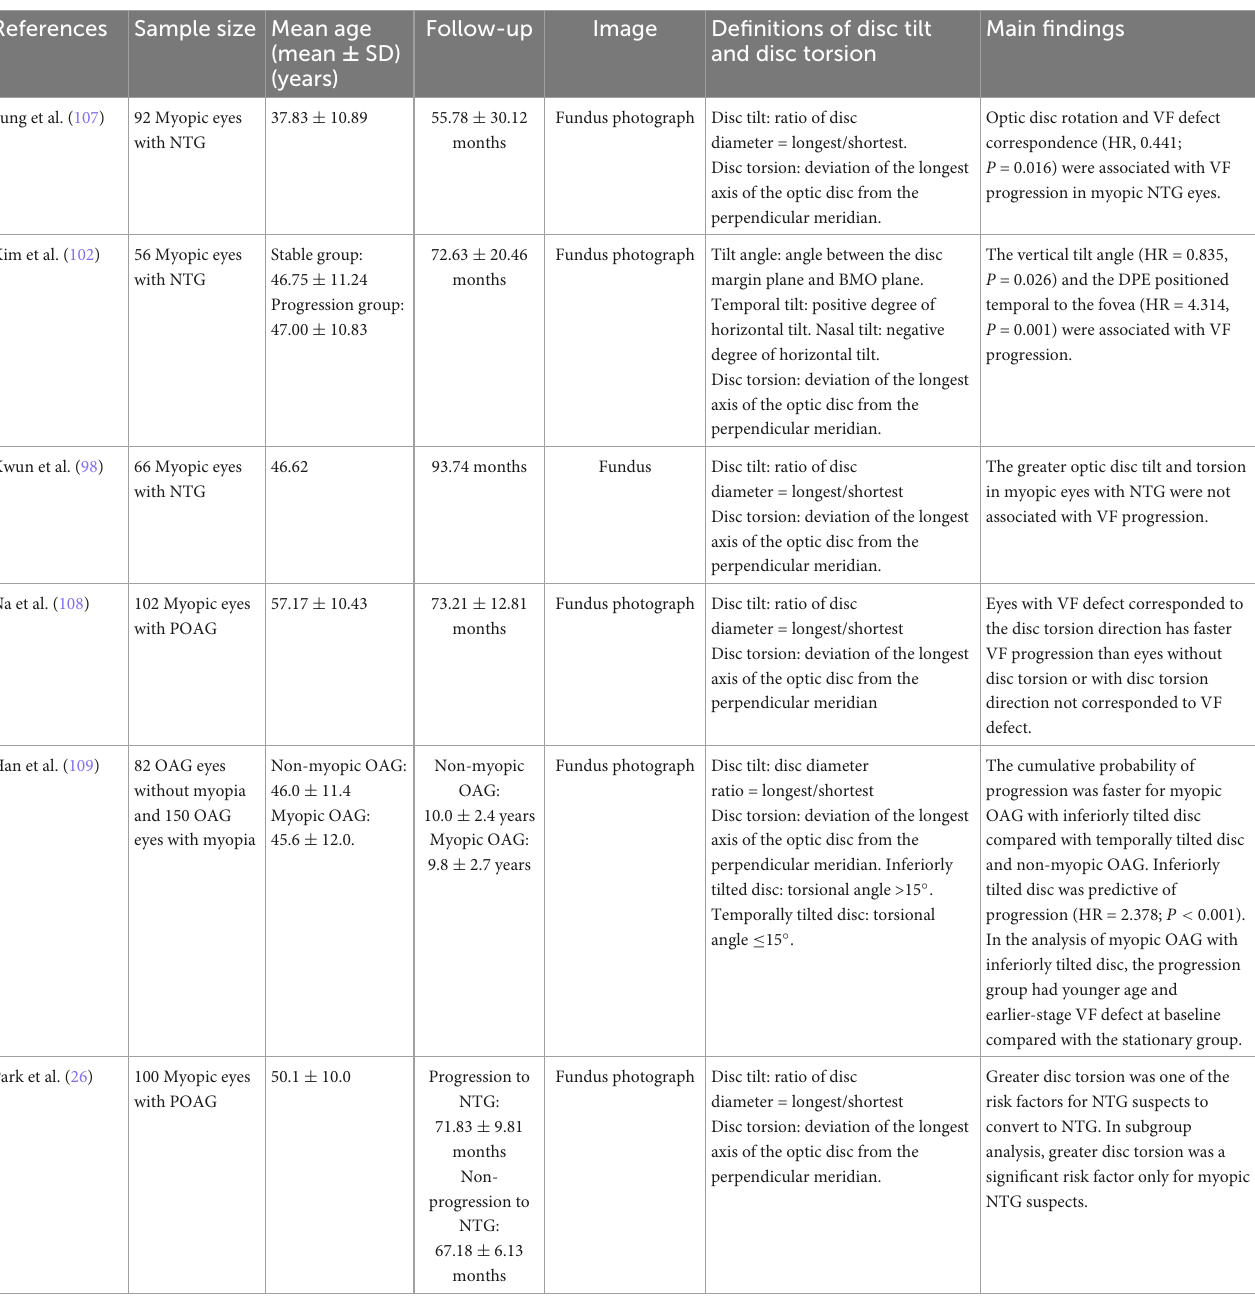
Fundus photograph Disc tilt: ratio of disc diameter = longest/shortest Disc torsion: deviation of the longest axis of the optic disc from the perpendicular